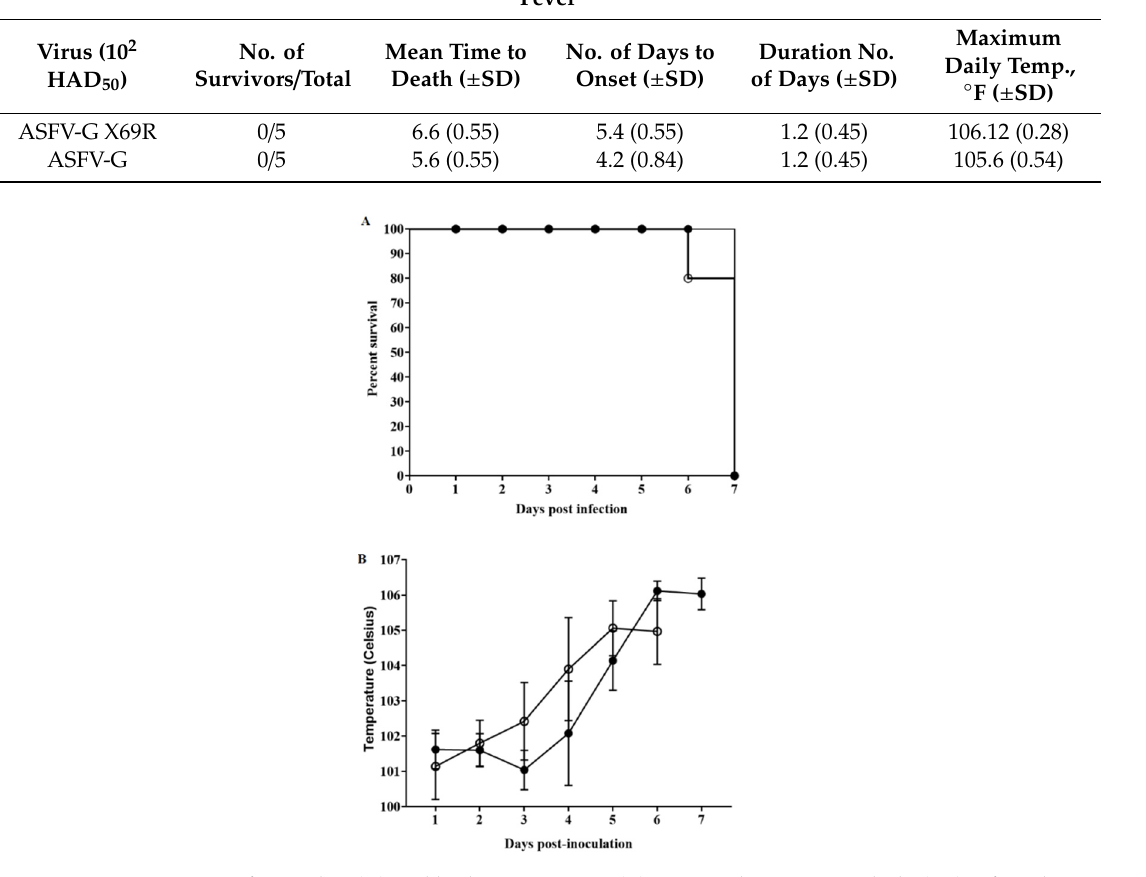
Figure 5. Progress of mortality ( A ) and body temperature ( B ) in animals intramuscularly (IM) infected with 10 2 HAD 50 of either ASFV-G- ∆ X69R (filled symbols), or parental ASFV-G (open symbols). Panel ( B ) shows average data and the corresponding SD.